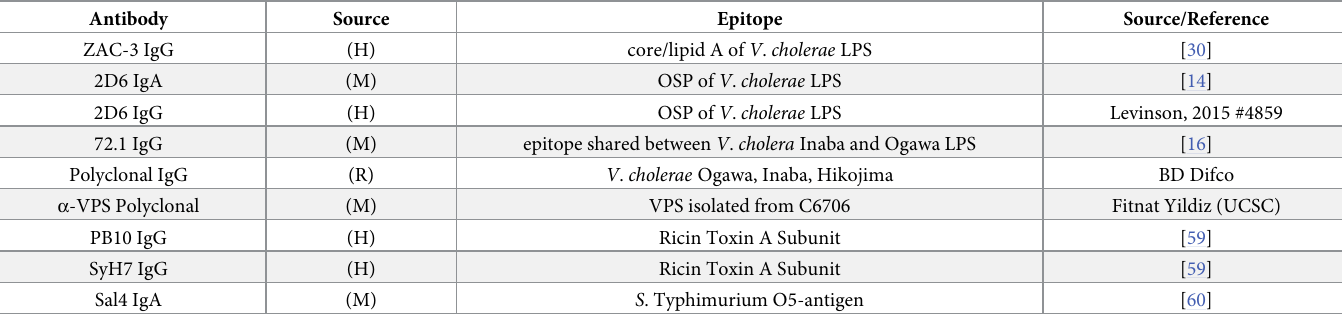
Table 3. Antibodies used in this